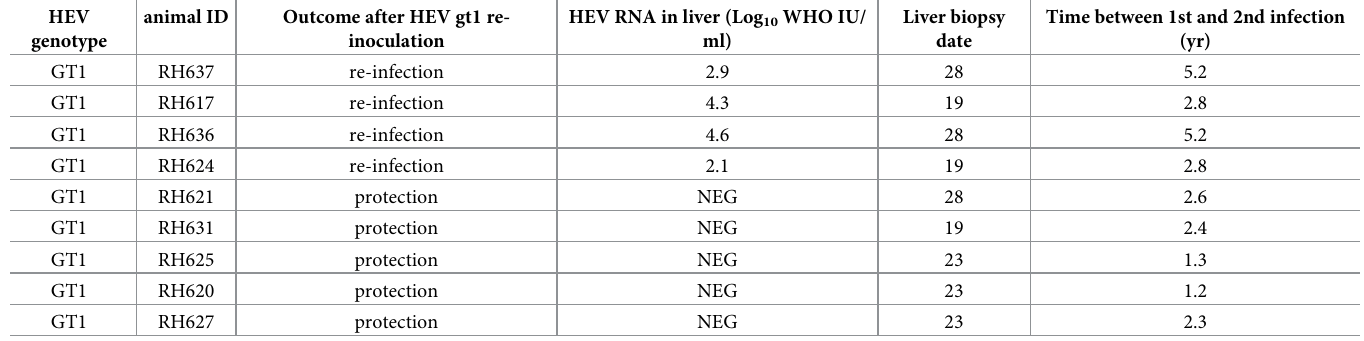
Table 3. Liver biopsy sample of the animals with homologous HEV gt1 reinfection used for RNA sequencing. HEV animal ID genotype